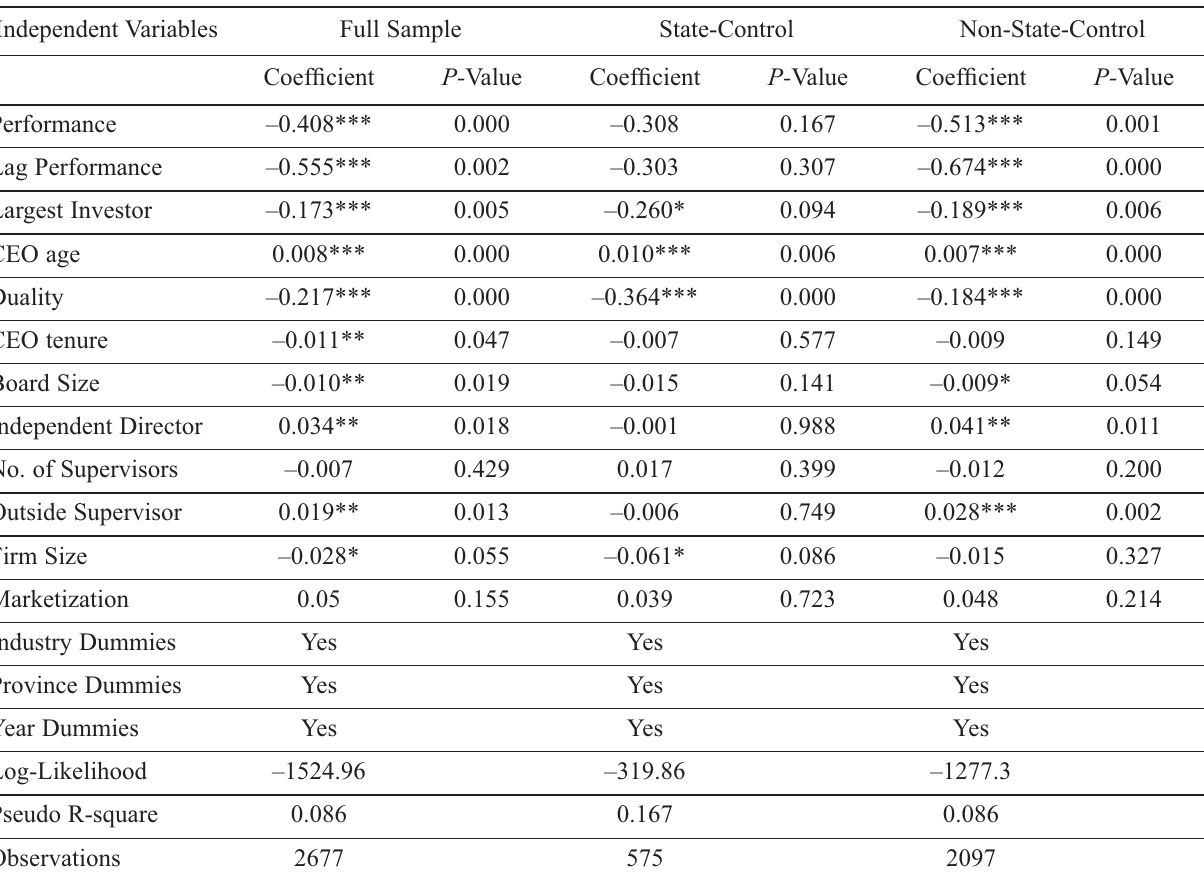
Table 5. Probit regression analysis of CEO turnover at the publicly listed fi rms in China The models are estimated using fi rm-level data of the fi rms listed on the Shanghai or Shenzhen stock exchanges in